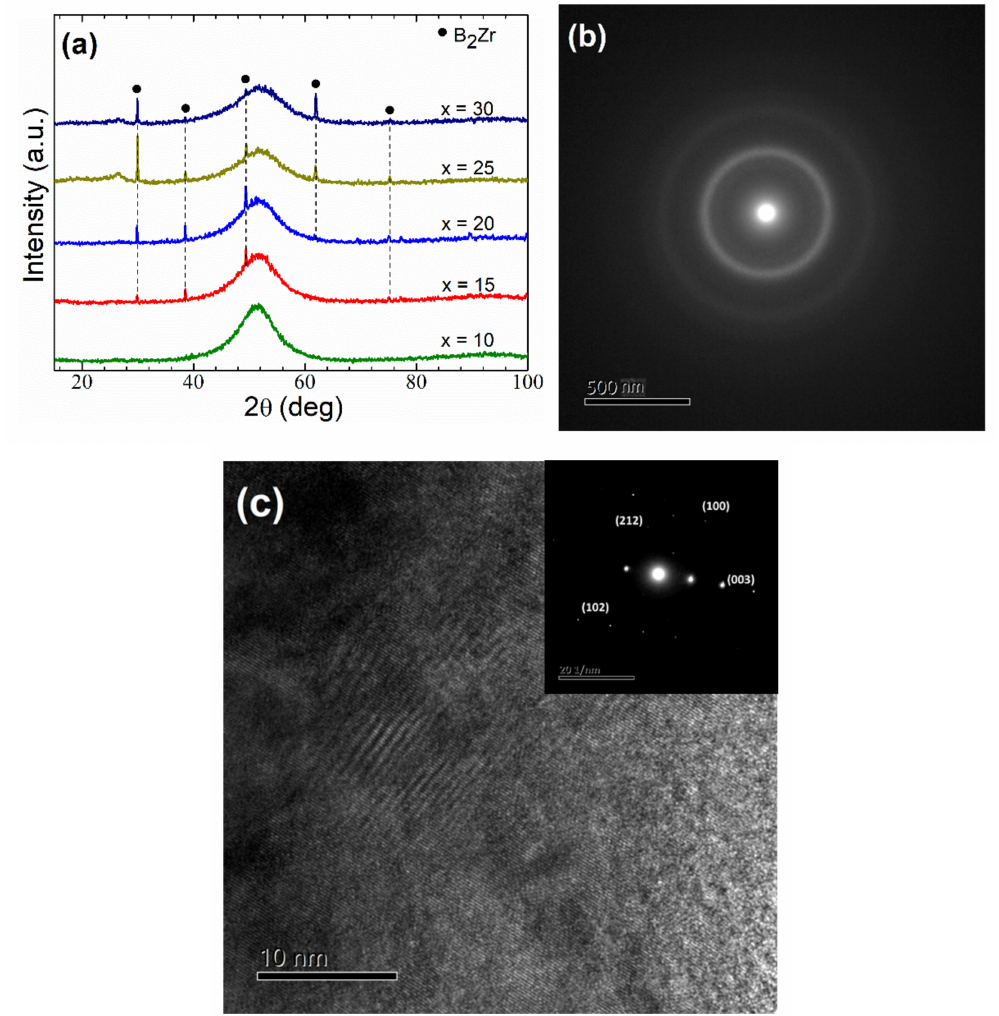
Figure 1. ( a ) XRD pattern and TEM micrograph ( b ) for the melt-spun amorphous alloys (x = 10 at% B) and ( c ) region with partial crystallization of the amorphous matrix for x = 30 at% B sample. Inset: TEM micrograph and the corresponding selected-area diffraction pattern